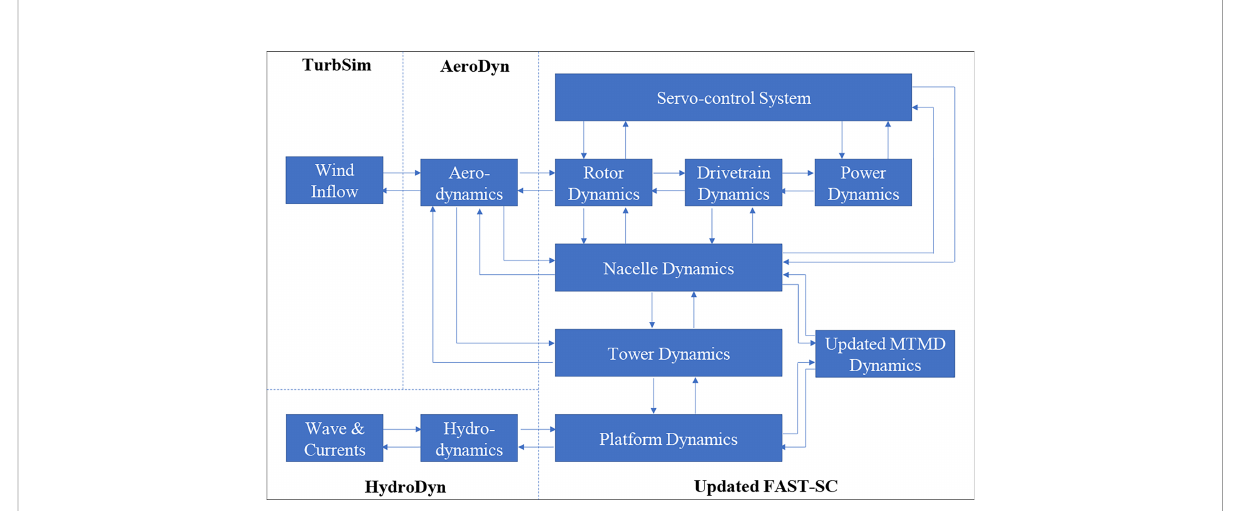
FIGURE 3 Schematic of the fully coupled model of FOWT with MTMD in the updated